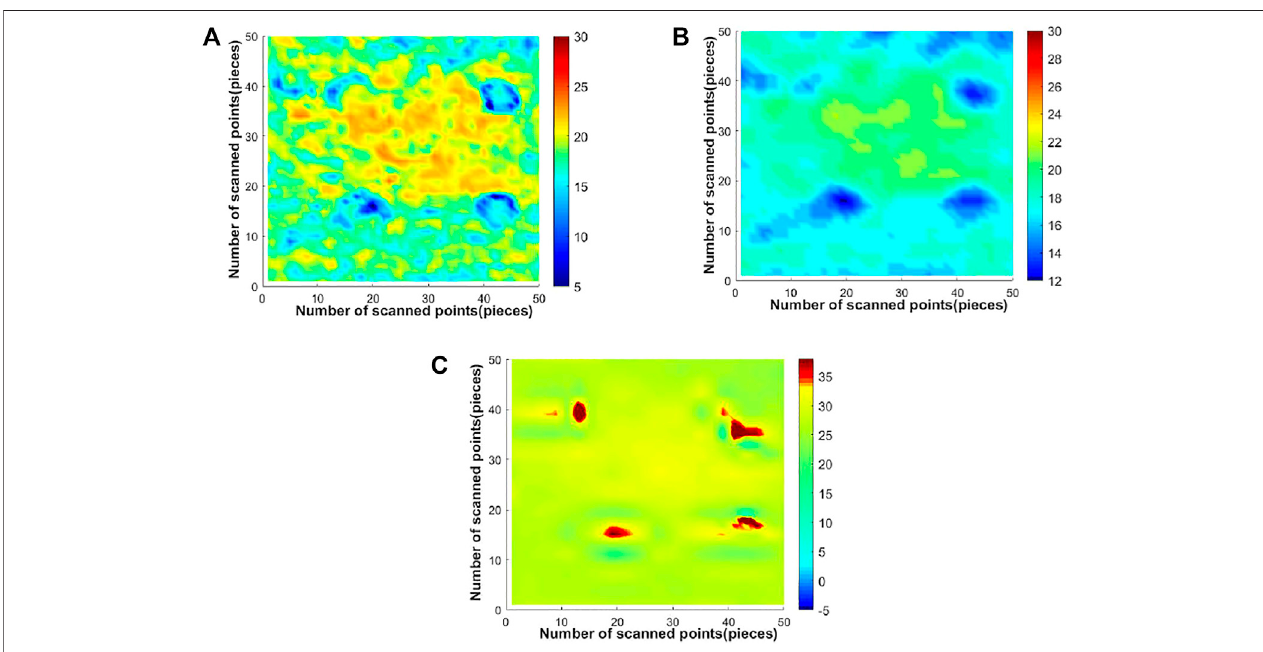
FIGURE 6 | Image of processing results of each method for adhesive debonding with a diameter of 10.0 mm in sample 1. (A) image of original detection, (B) Gaussian fi ltering, (C) method in this paper.